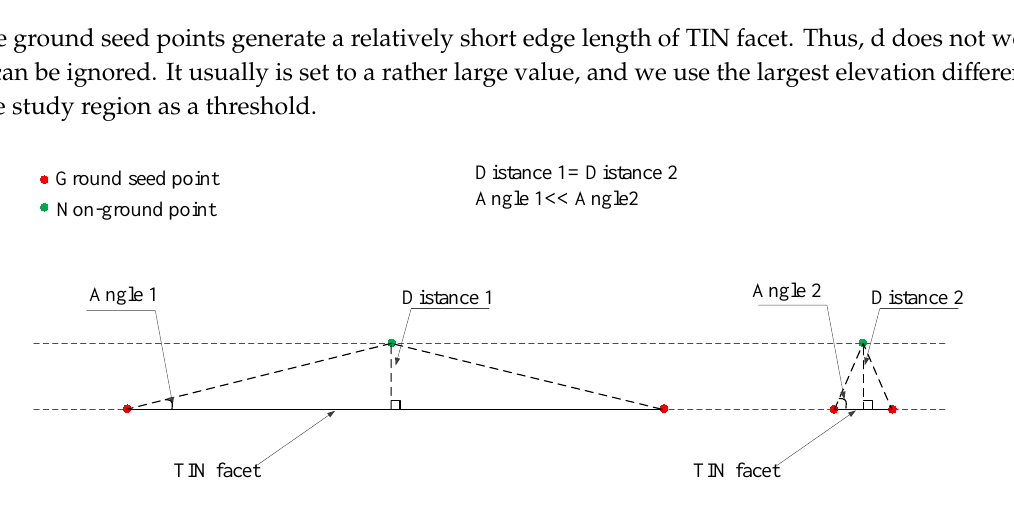
Figure 11. Simple demonstration of the maximum distance threshold setting.